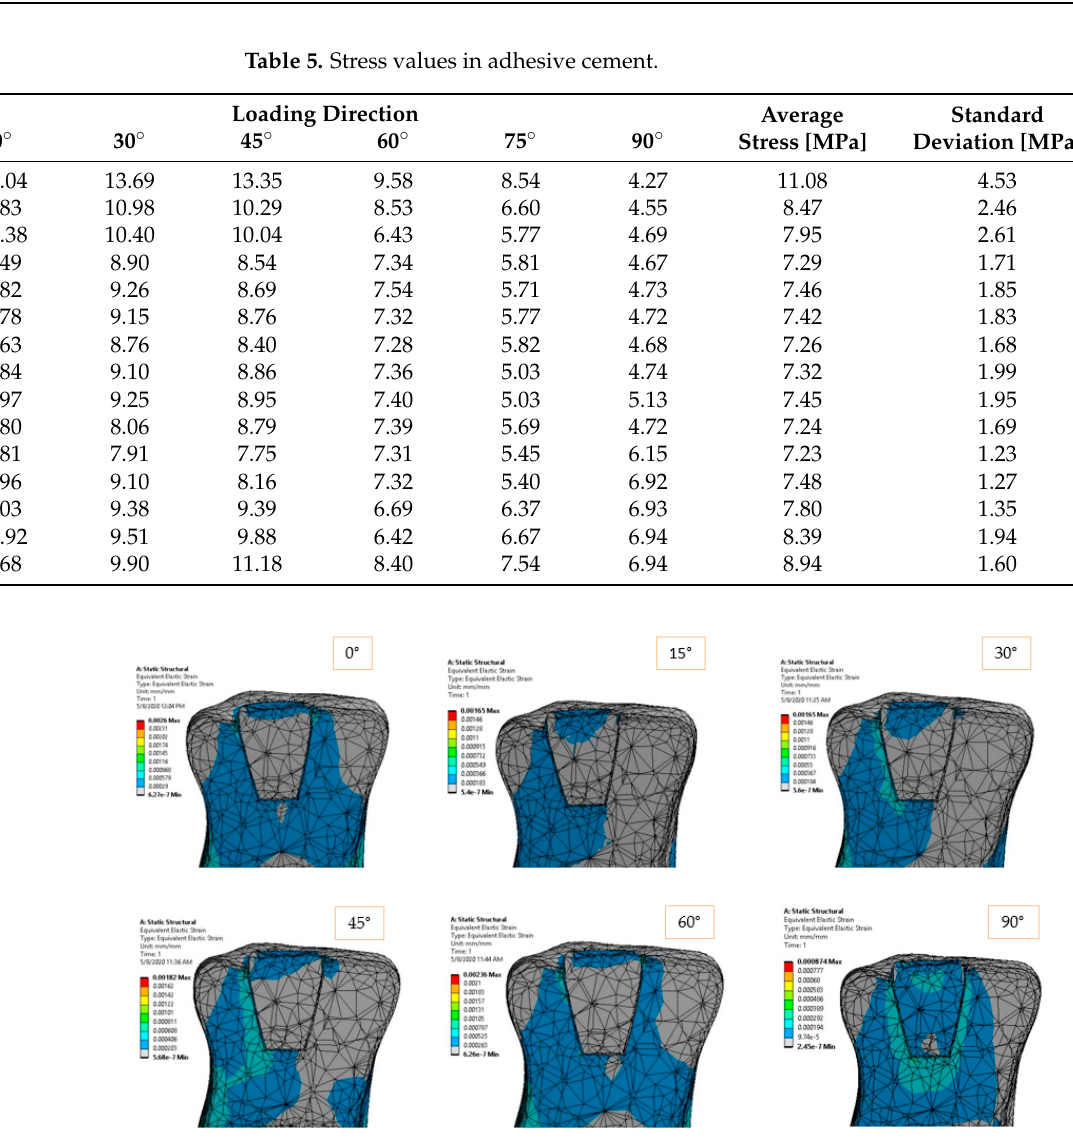
Figure 8. Equivalent elastic strain for 170 N load and 0°–90° loading direction.